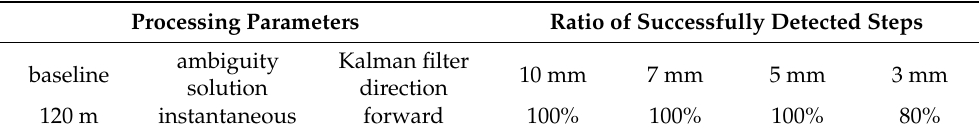
Figure 16. Automated tiny shift detection based on deformation. The antenna was quickly moved repeatedly 5 mm distance per step. The blue dot line is the apparent displacement derived from the short baseline solution. The red line is the deformation after applying the moving average filter method. Table 6. Evaluation of horizontal shift from 10 mm to 3 mm.